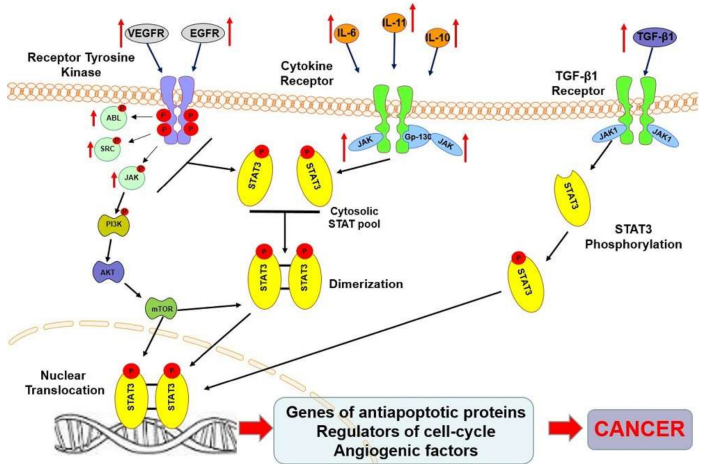
Figure 1. Schematic representation of the signaling pathways leading to signal transducer and activator of transcription 3 (STAT3) activation. Increased levels (indicated by red arrows) of IL-6, IL-10, IL-11, VEGF, EGFR, TGF- β , JAK, Abl, or Src lead to an increase in the rate of phosphorylated form of STAT3 protein (marked with P)-P-STAT3. Moreover, increasing the intracellular JAK level activates the mTOR pathway, which can increase the level of STAT3 dimerization both in the cytoplasm and in the nucleus. Upregulated pSTAT3 levels can lead to increased expression of genes encoding anti-apoptotic proteins, cell cycle regulators, or angiogenic factors. All of this, as a consequence, can induce the formation of neoplastic cells